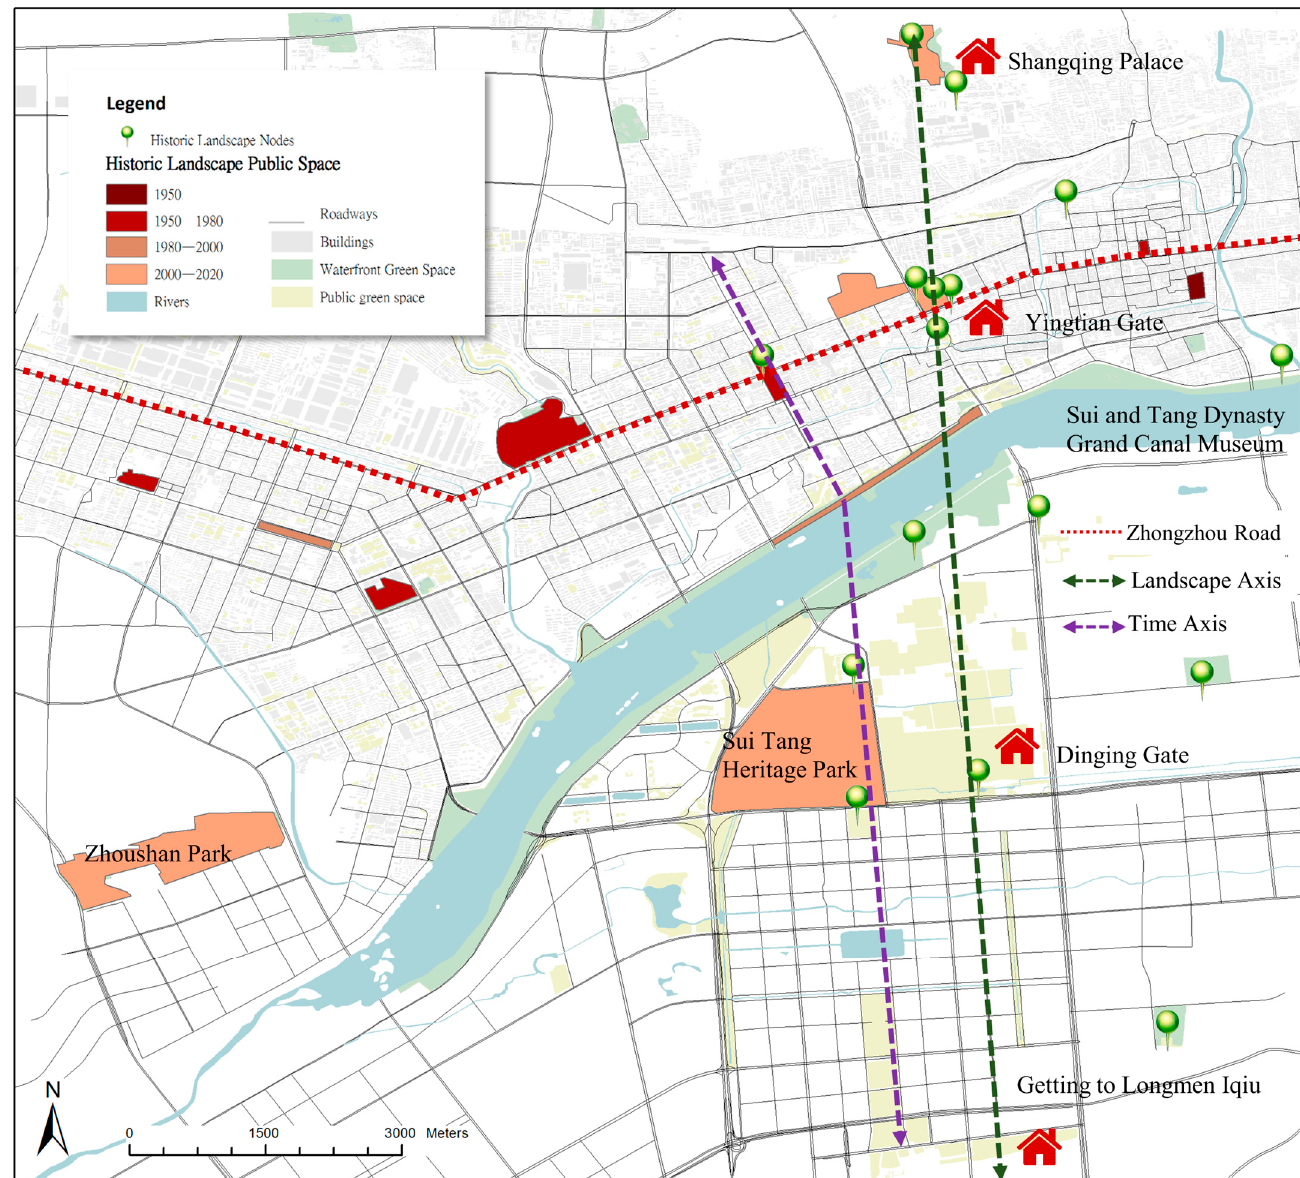
Figure 7. Historical landscape layers of Luoyang in the period of rapid urbanization. (Adapted ac- cording to an urban map of Luoyang from 2019.).